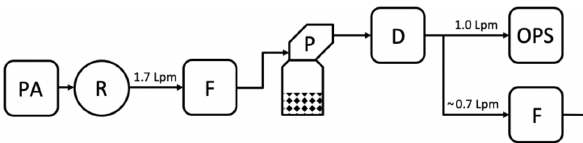
Figure 2. Schematic of the experimental setup used in this study. A dry pressurized-air flow (PA) was passed through a rotameter (R) to control the flow rate and a filter (F) upstream of PROTeGE (P). Generated droplets were dried with silica gel (D) before the flow of particles was directed into an OPS with excess flow discarded through a filter